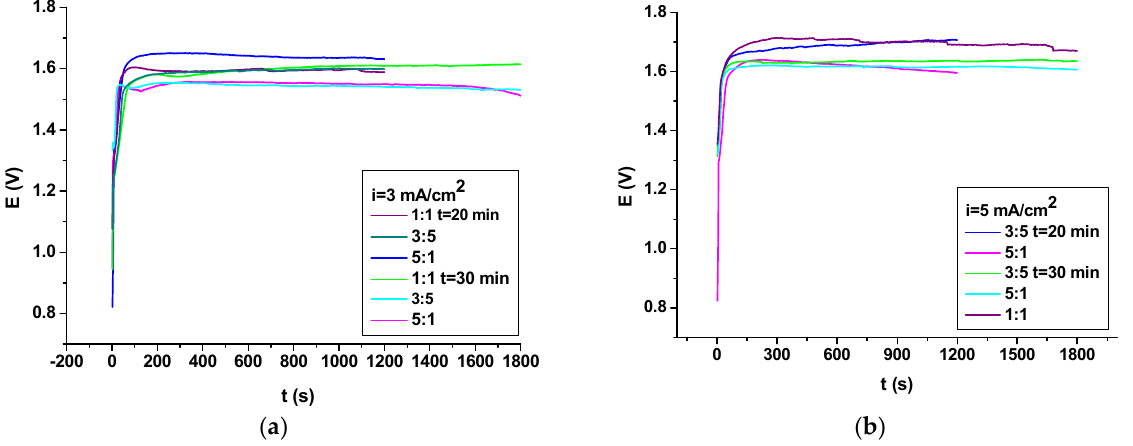
Figure 1. Galvanostatic deposition of PNMPY-TW20/P3MT/OLC 45 at current densities ( a ) 3 mA/cm 2 and ( b ) at 5 mA/cm 2 for 1200 s and 1800 s to different molar ratio for PNMPY-TW20 and